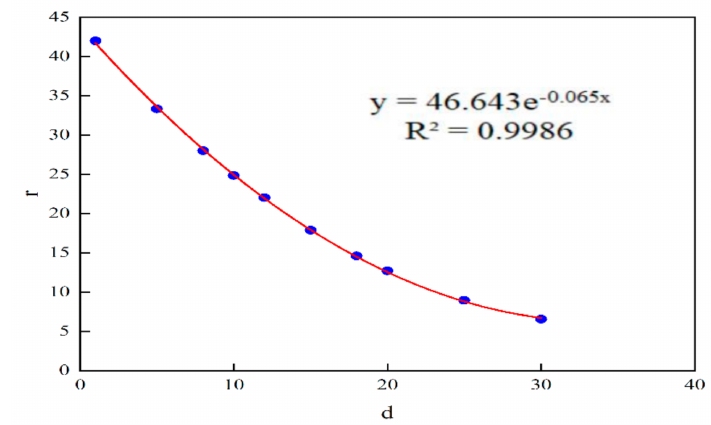
Figure 10. The relation curve between the safety limit value r of the horizontal/vertical ratio and permeability level difference d in the well